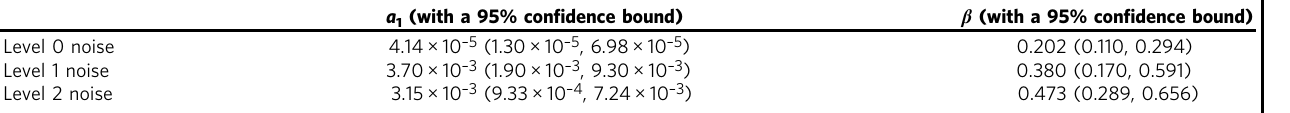
a fi dence bound) β (with a 95% con fi dence bound) 1 (with a 95% con